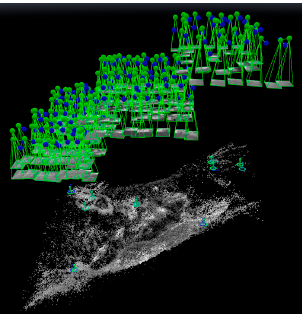
Figure 11. The result of GNSS-supported self-calibration AT using control strategy D.